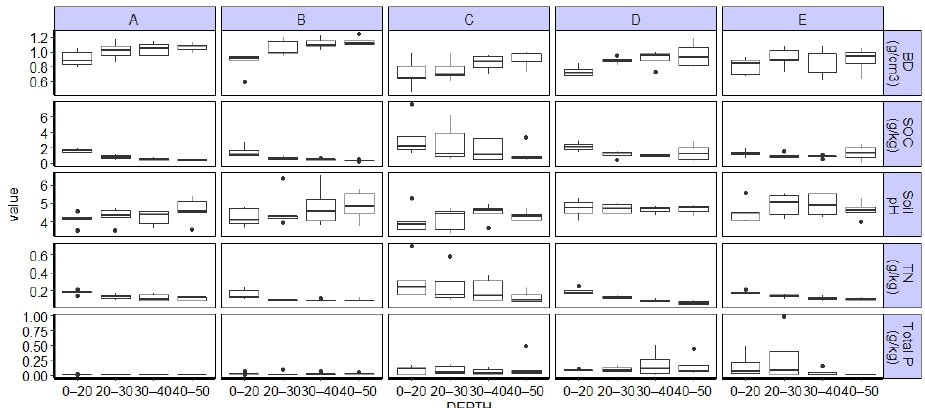
Figure 6. Boxplots for BD, SOC, soil pH, TN, and TP as regards farming practices A, B, C, D, and E and soil depth within the study area. A = traditional flood irrigation (rainfed) without intensification of rice farming; B = traditional flooding (rainfed) with rice intensification (SRI); C = AWD farming practice involving SRI with one cropping season; D = abandoned fields; and E = AWD farming practice involving SRI with two seasons.